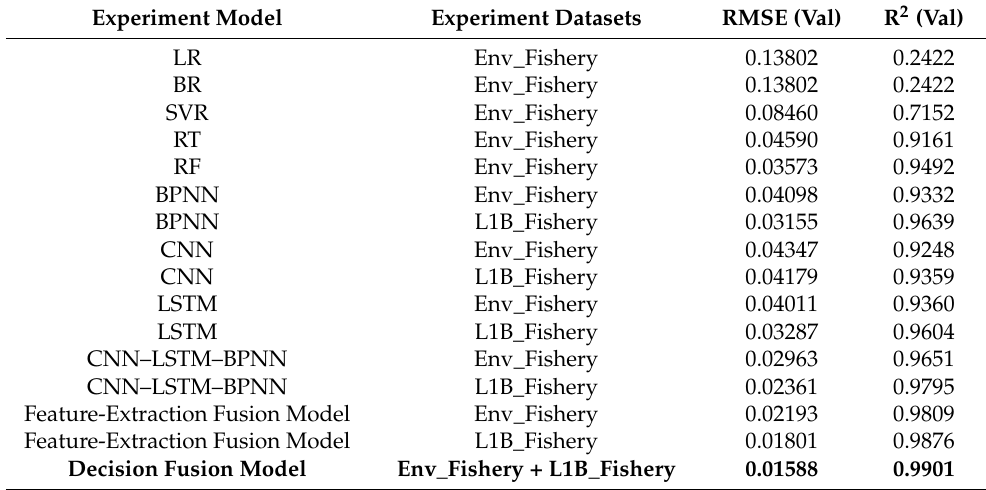
Table 5. Comparison of the results of different models in the model validation